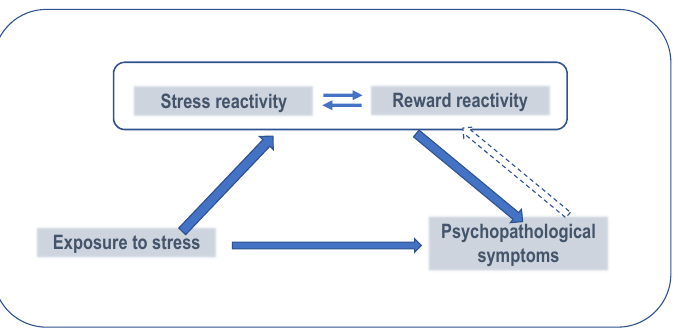
symptomsExposure to